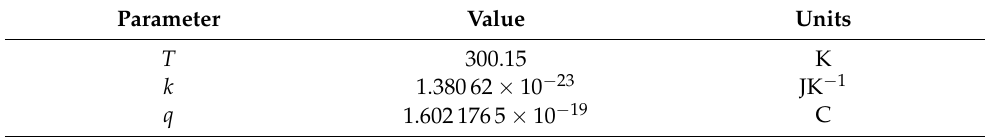
Figure 19. Nonlinear fit of D f for large positive DC voltages for the three diodes. Table 4. Forward bias curve fitting parameters for the three diodes.